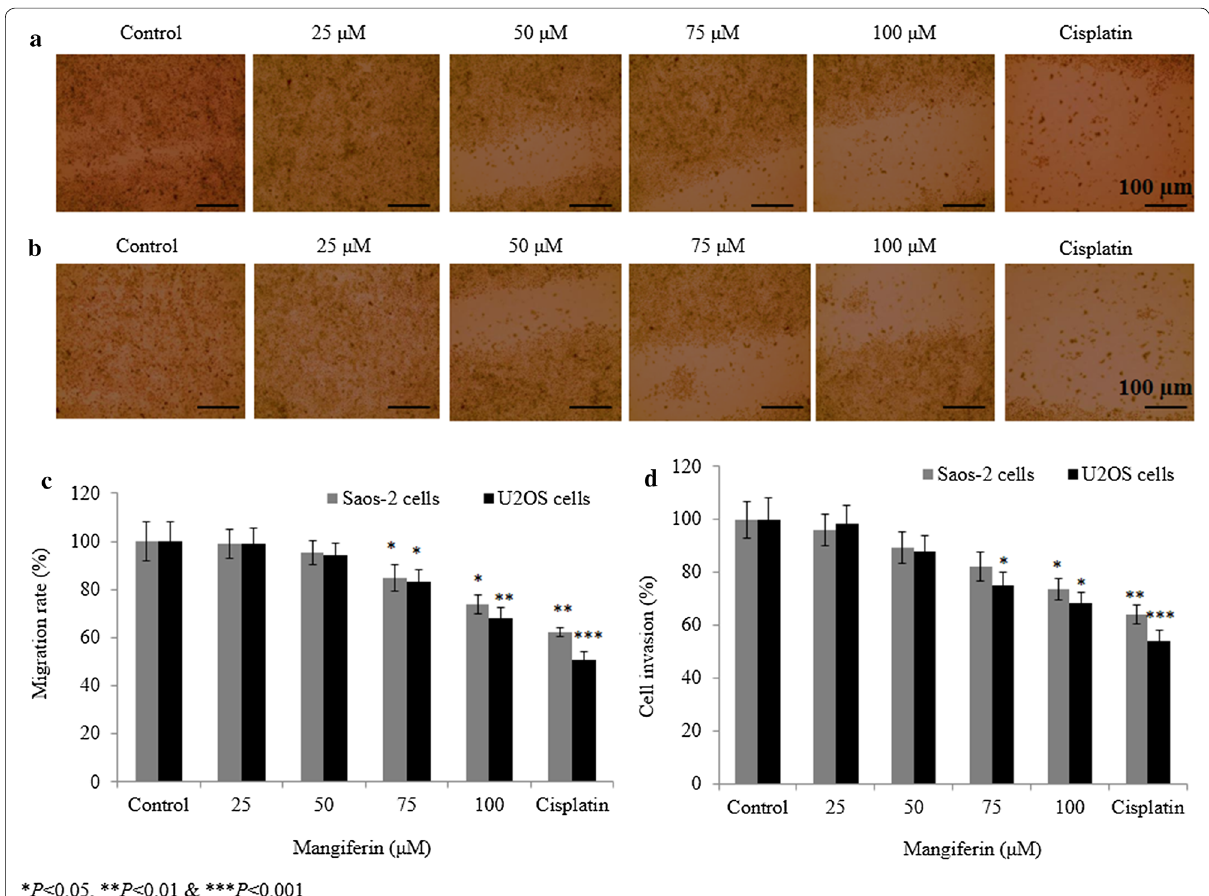
Fig. 5 Effect of mangiferin on cell migration and invasion. Cells were incubated with mangiferin (25–100 µM) for 72 h. a representative microscopic images of the Saos-2 cell migration assay, b representative microscopic images of the U2OS cell migration assay, c percent migration rate and d percent cell invasion. N 6. Control vs. * P < 0.05. Scale bar is 100 =